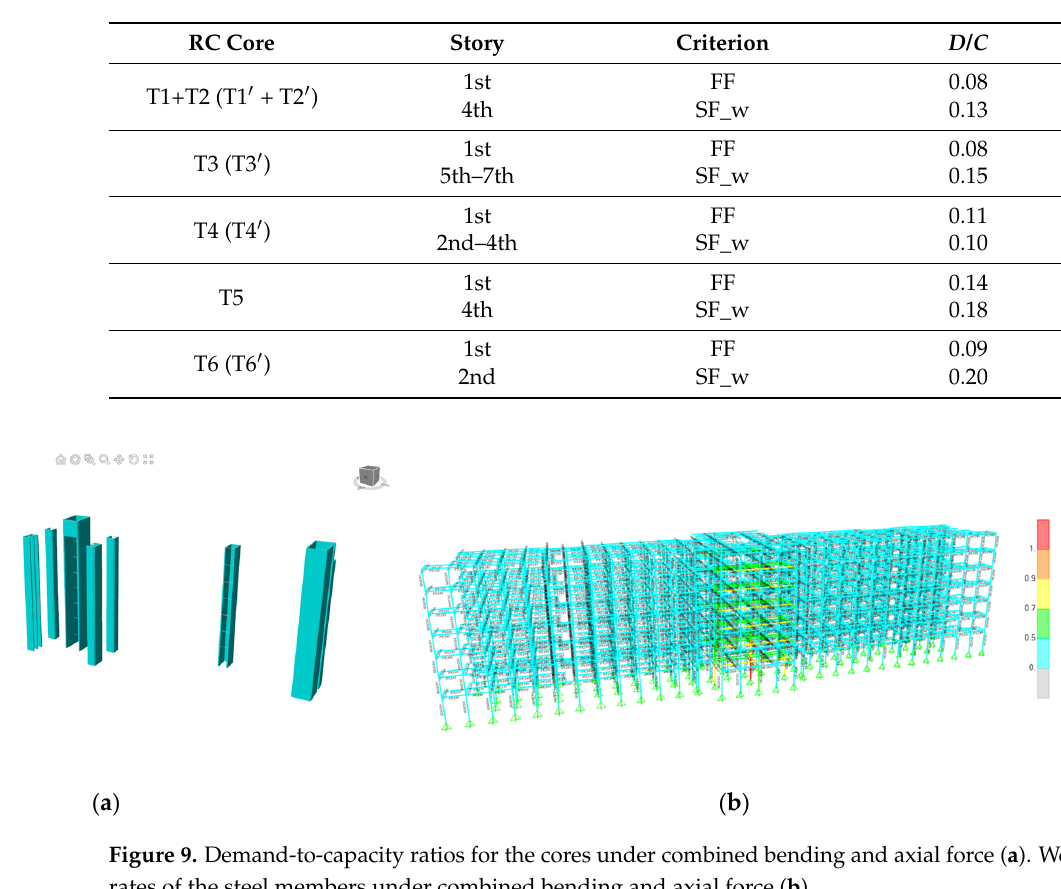
Table 8. Main numerical results of RC cores under vertical actions.